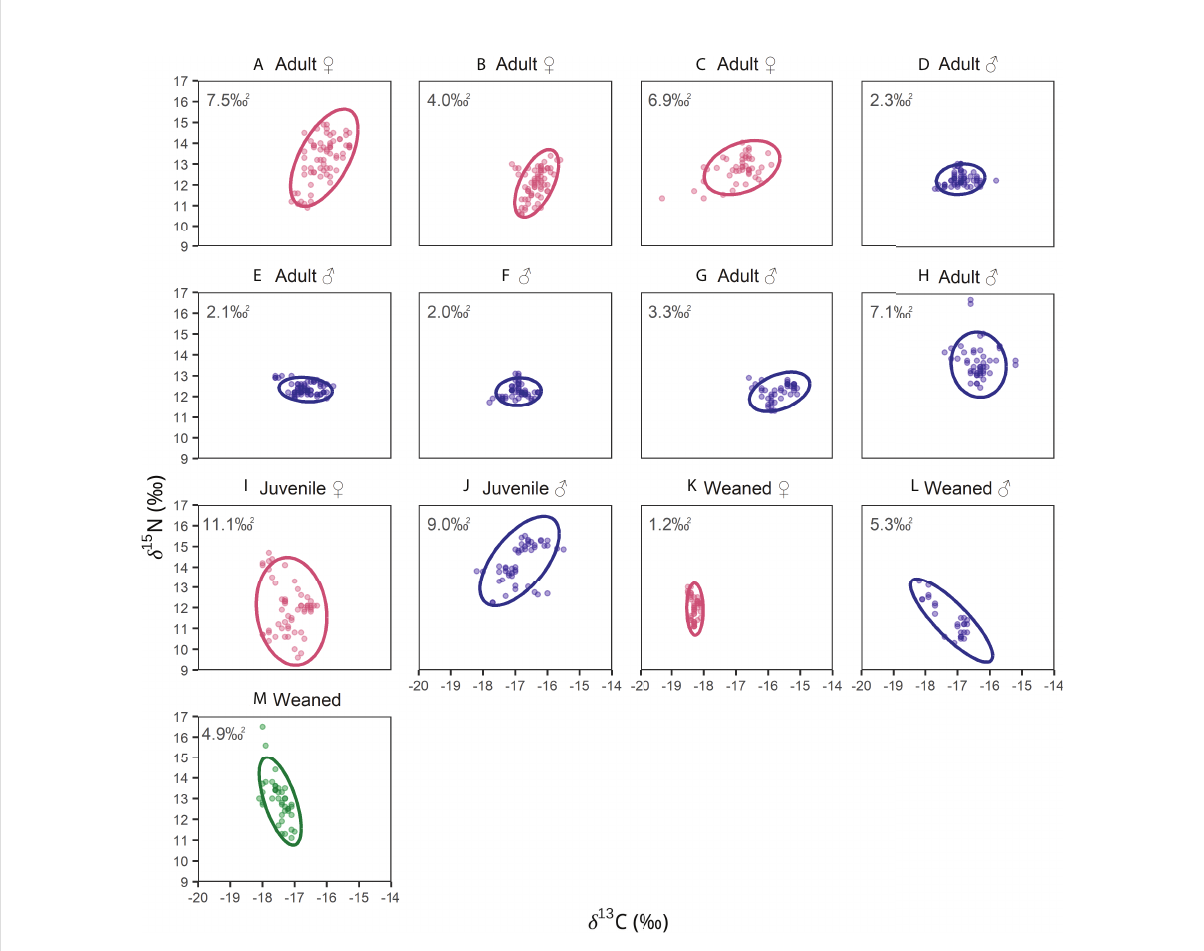
FIGURE 7 Isotopic niche width (solid lines-SEA ‰ 2 ) of blue whales in the northeast Paci fi c. d 13 C values were Suess corrected for isotopic niche estimations. Color indicates sex of the whale: females (red), blue (males), and sex not identi fi ed (green); posterior mean estimates of SEA B ( ‰ 2 ) are reported for each whale in the top-left of the panels. Figure shows whales (A – M)